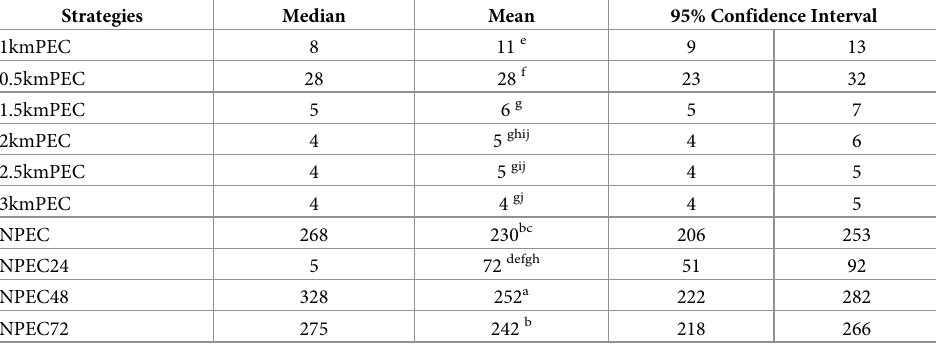
Table 4. Comparison of the total number of poultry farms culled estimated for the different control strategies. Strategies Median Mean 95% Confidence Interval 1kmPEC 118 134 j 117 150 0.5kmPEC 176 141 hj 121 162 1.5kmPEC 135 142 gj 129 154 2kmPEC 185 179 f 168 190 2.5kmPEC 199 201 de 191 211 3kmPEC 220 203 d 191 216 NPEC 268 230 bc 206 253 NPEC24 5 72 k 51 92 NPEC48 328 252 a 222 282 NPEC72 275 242 b 218 266 Means with different superscripts in each column were statistically